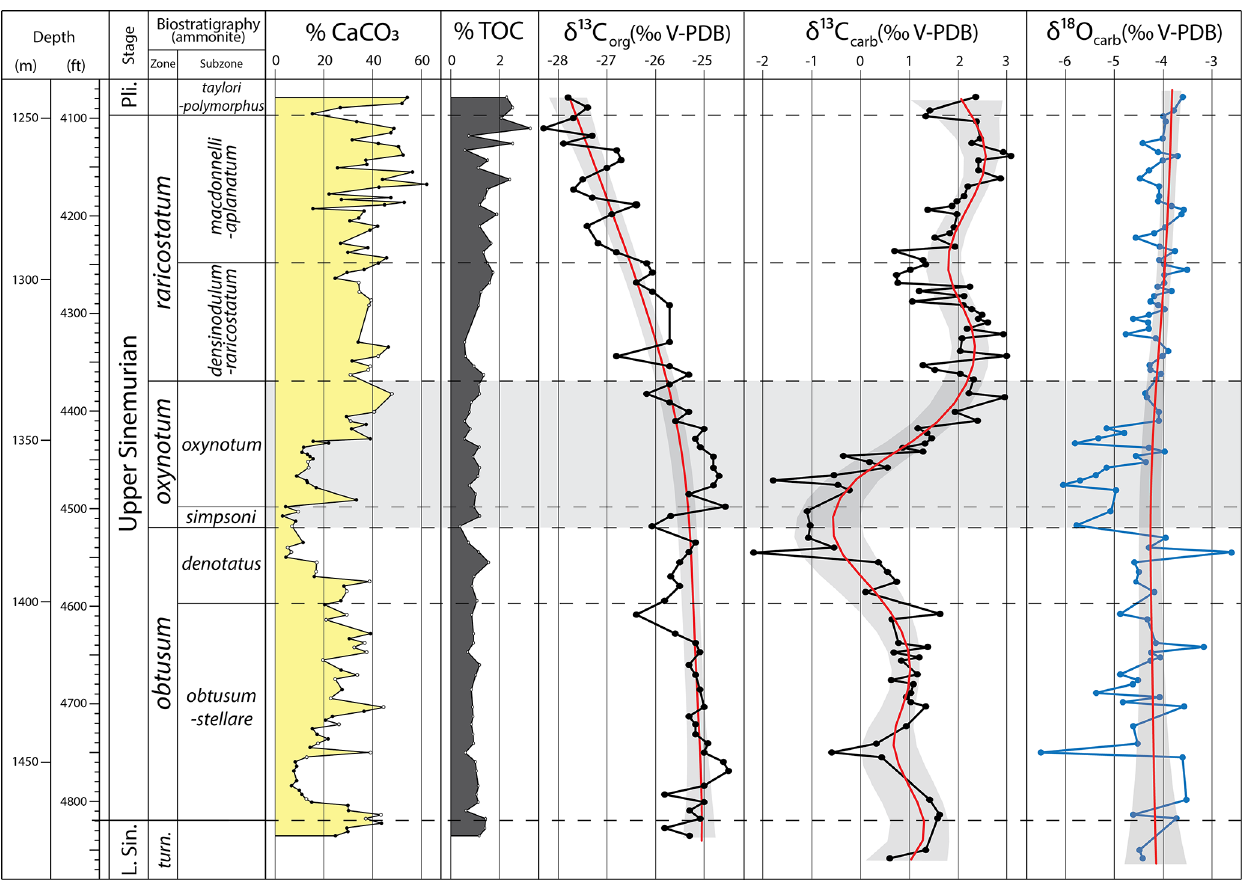
Figure 7. Carbon ( δ 13 C carb and δ 13 C org ) and oxygen ( δ 18 O carb ) isotopes of the upper Sinemurian in the Mochras borehole coupled with the proportions of CaCO 3 and TOC. The smoothing curve is in red, and the 95% confidence interval is in grey (kernel regression). L. Sin. – lower Sinemurian, Pli. – Pliensbachian, turn. – turneri